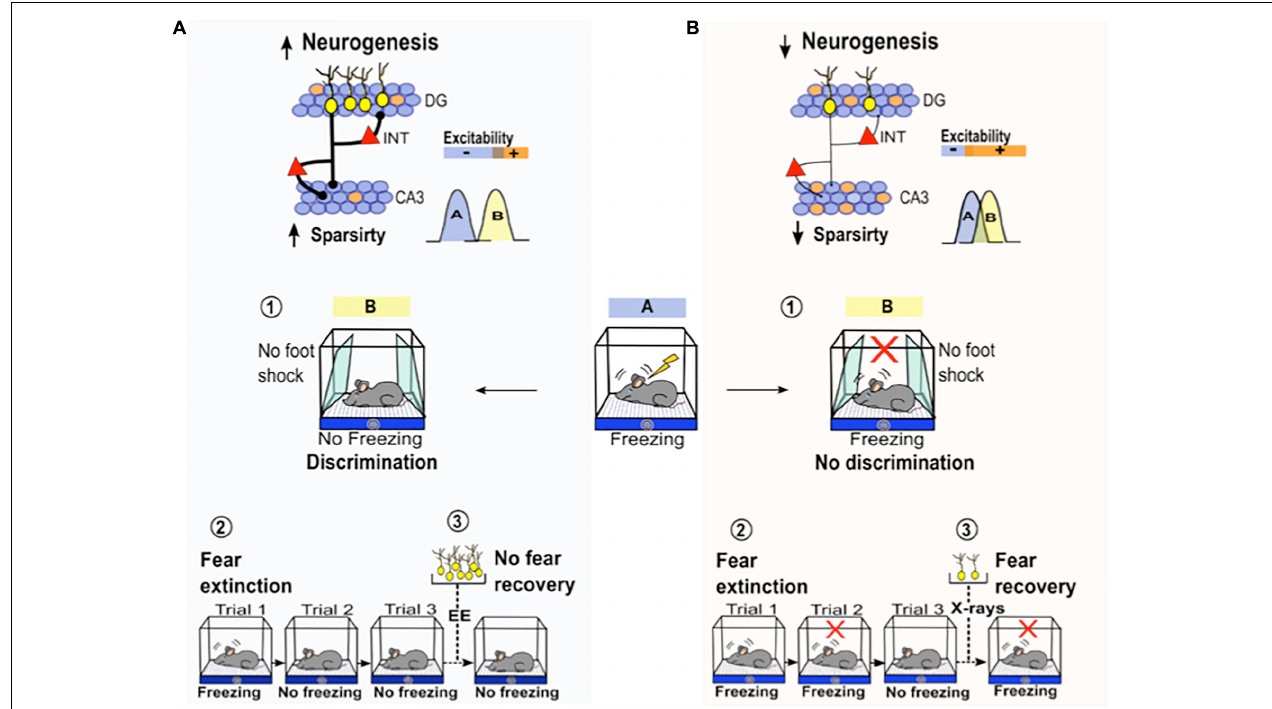
FIGURE 2 | The roles of adult neurogenesis in different contextual fear-related behaviors. (A) Activation of adult born- neurons (yellow neurons) activates GABAergic inhibitory interneurons (red triangles) in the DG and CA3 (Restivo et al., 2015; Temprana et al., 2015), which may increase sparsity activity in the DG-CA3 circuit potentially promoting pattern separation. Left below, the function of pattern separation prevents interference among different neuron population codes that are active during two similar experiences: A (blue) vs. B (yellow). This process facilitates the ability of the animal to discriminate between the conditioned context (A, blue) and a similarly close safe context (sloping walls, B yellow, (cid:192) ). Through this mechanism, AHN may promote fear memory extinction by reducing the interference between an old aversive memory association (context with foot shock) and a new safe association (context with no foot shock, (cid:193) ). After fear memory extinction, the increase in AHN by environmental enrichment (EE) prevents spontaneous fear recovery (cid:194) . (B) A decrease in adult born- neurons reduces sparsity activity in the DG-CA3 circuit which may impair pattern separation (Niibori et al., 2012; Denny et al., 2014). Bottom right, low neurogenesis impairs pattern separation, which decreases the ability of an animal to discriminate between closely similar contexts (cid:192) . Impairment in pattern separation due to low neurogenesis may also impair fear memory extinction. Rodents with low neurogenesis are not able to reduce the conditioned fear response (freezing) as efficiently as mice with normal levels of neurogenesis (trial 2 vs. trial 3) during extinction training (cid:193) . The reduction in AHN by irradiation (X-ray) promotes spontaneous fear recovery (cid:194)